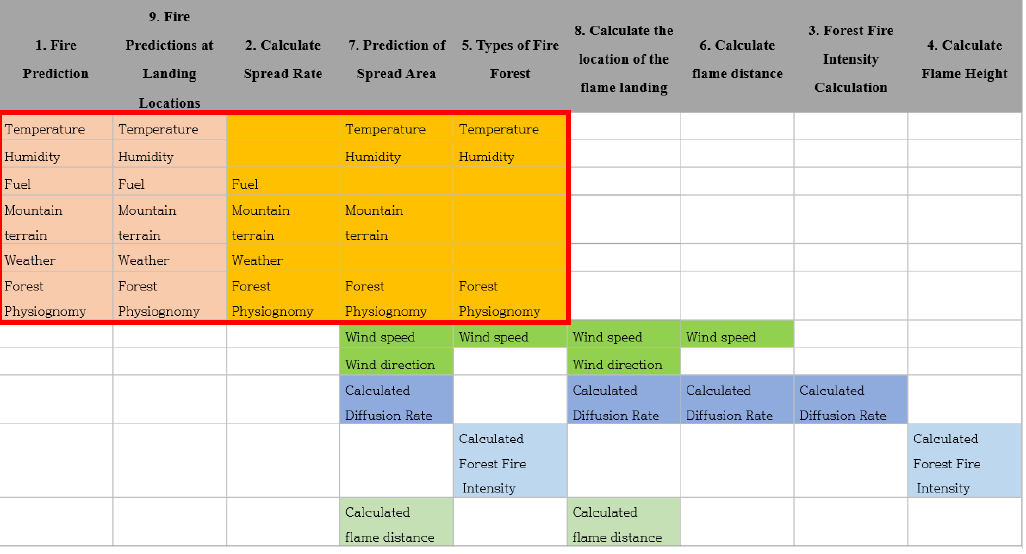
Figure 2. Tasks re ‐ arranged in order based on algorithm. Figure 2. Tasks re-arranged in order based on